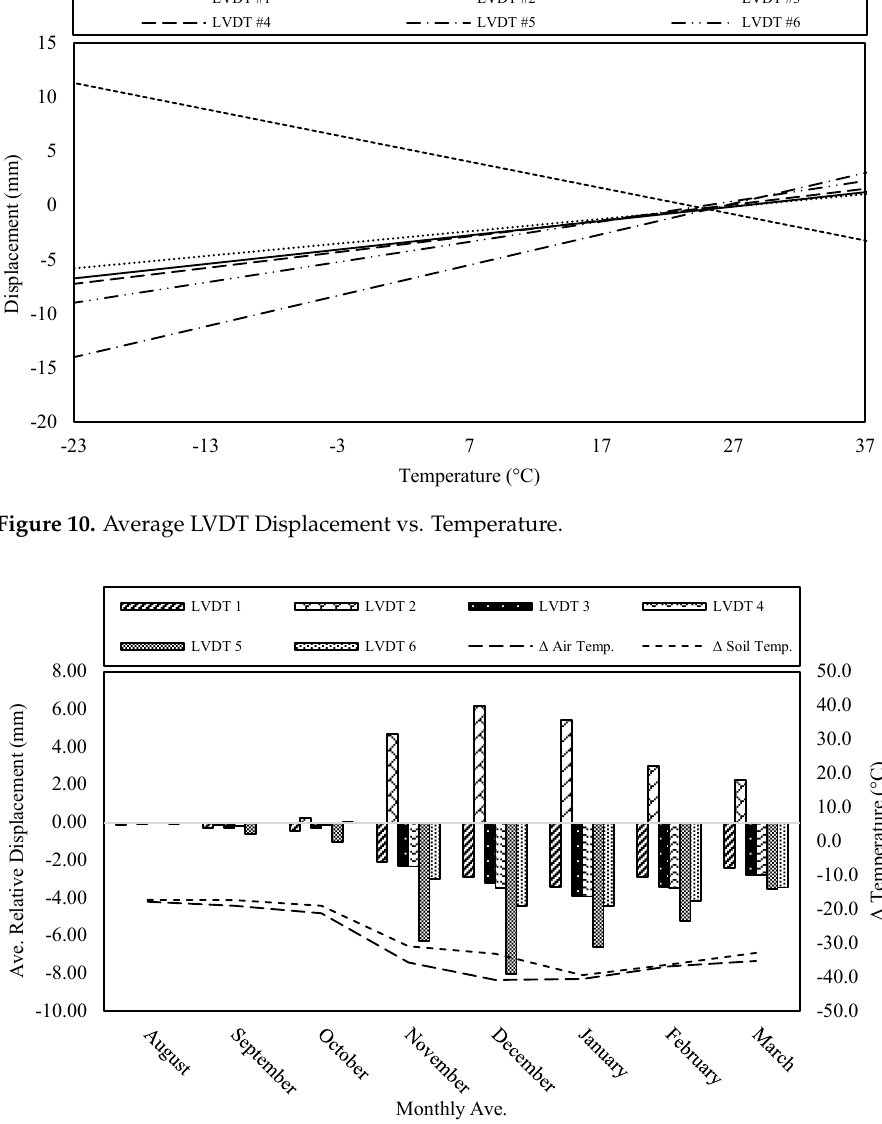
Figure 11. LVDT Monthly Ave. Relative to Temperature.